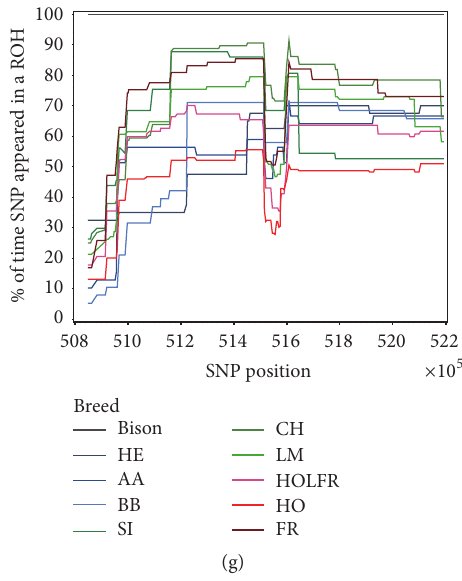
Figure 2: Examples of the investigated patterns. (a) A simultaneous increase (or decrease) in the number of SNPs in a ROH across all populations, as this pattern could possibly involve genes fundamental for the two species analysed (chromosome 3); (b) few populations showing an opposite pattern compared to the others, as this could comprise genes specific for those populations (chromosome 7); (c) different patterns between dairy and meat breeds, as this could possibly concern regions under human-induced directional selection (chromosome 2); (d) different patterns between bison and domestic cattle breeds, as this pattern may be related to traits important for survival in the wild (chromosome 3); (e) a single domestic breed differentiating from the others, as this could relate to specific characteristics of that breed (chromosome 14); (f) a long region with a high percentage of ROH, as this could be associated with recent selective events (chromosome 20); (g) a short region with opposite trend within a longer homogeneous region, to investigate what could have caused such an abrupt change in variability levels (chromosome